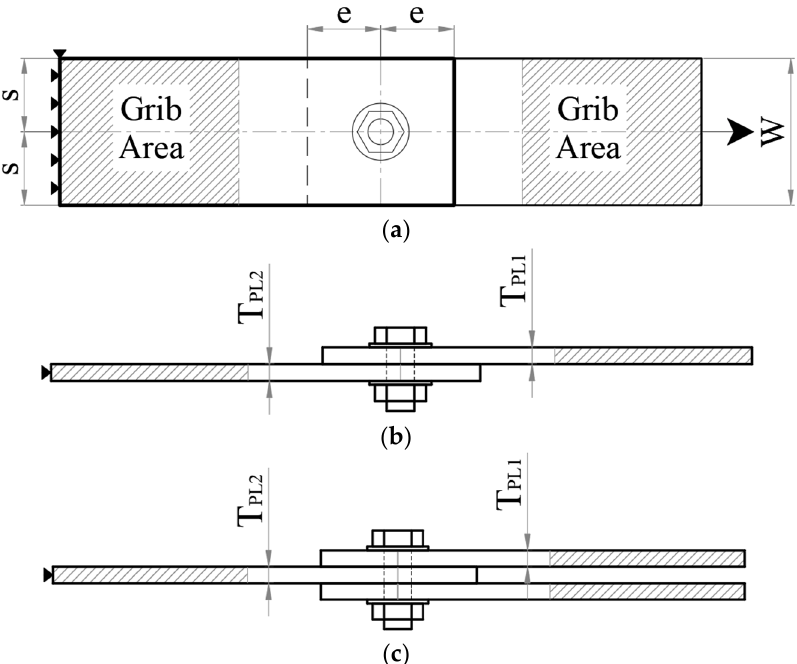
Figure 4. Geometric characteristics of composite-lapped joints: ( a ) Top view of a lapped joint, ( b ) side view of a single lapped joint, and ( c ) side view of a double lapped joint.